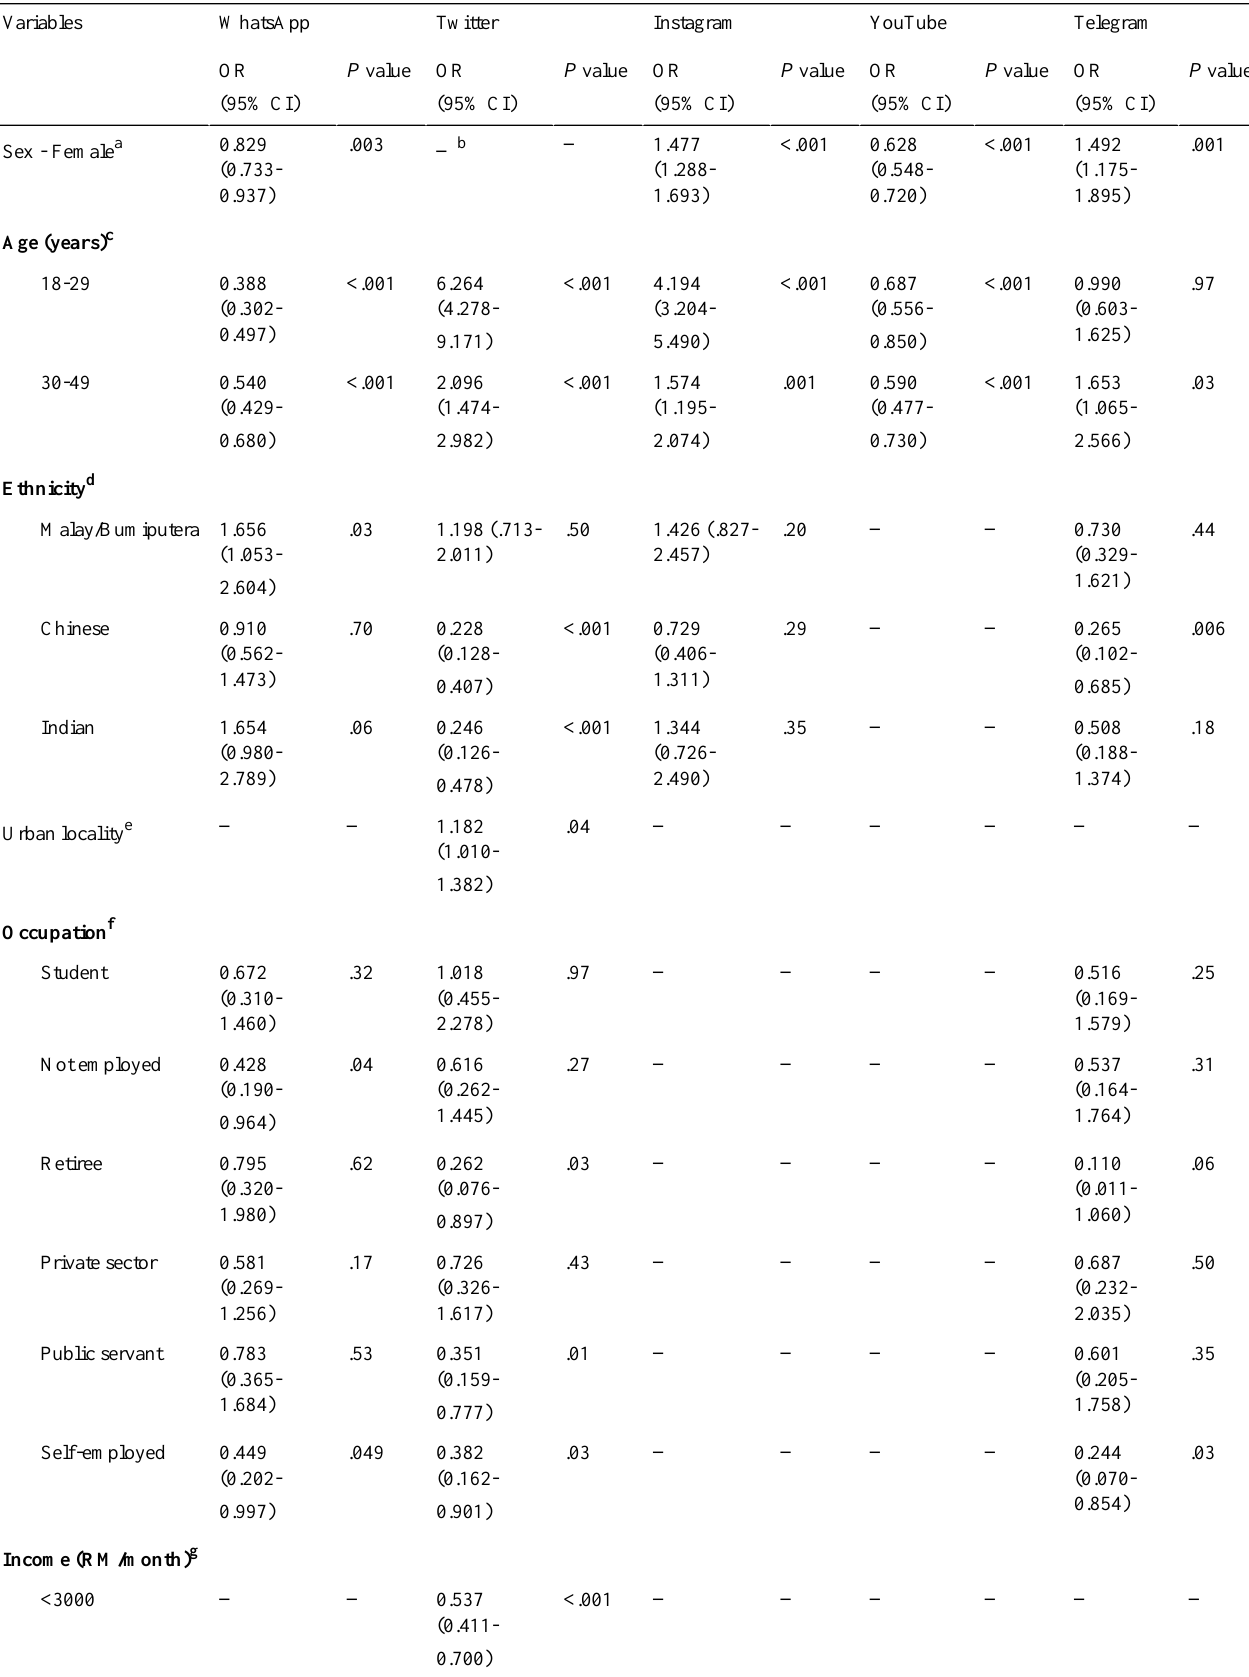
Table 3. Factors related to the use of COVID-19 social media information sources.